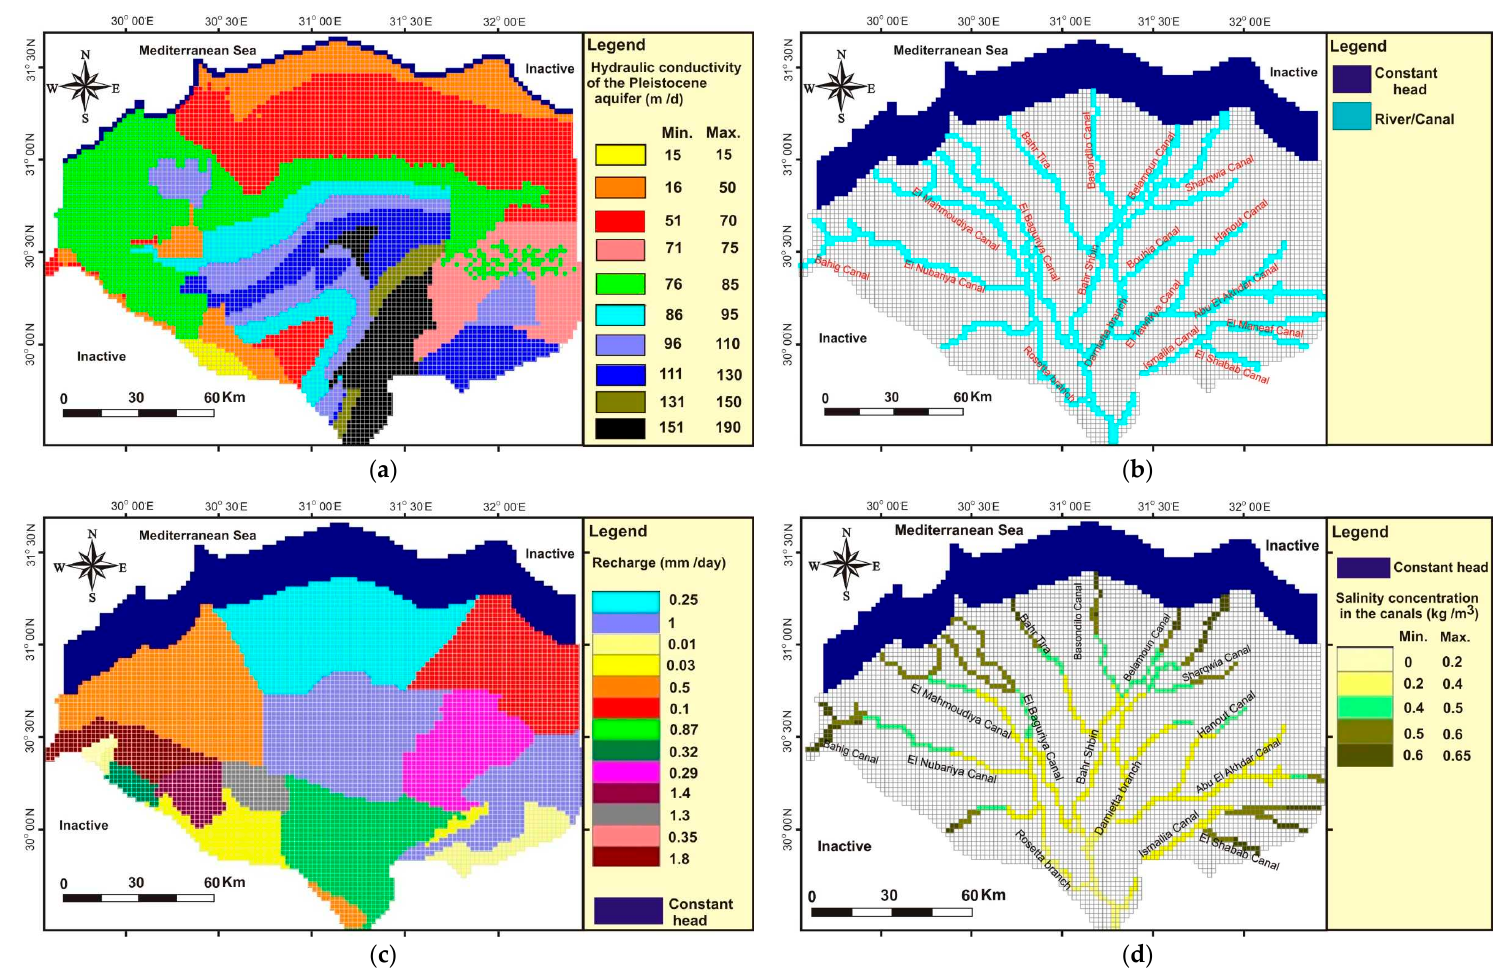
Figure 3. ( a ) The hydraulic conductivity of the Pleistocene aquifer of the Nile Delta. ( b ) Irrigation network. ( c ) Zones with different recharge rates in the Nile Delta. ( d ) The salinity concentration in kg/m 3 the river package, modified from data used in [5].